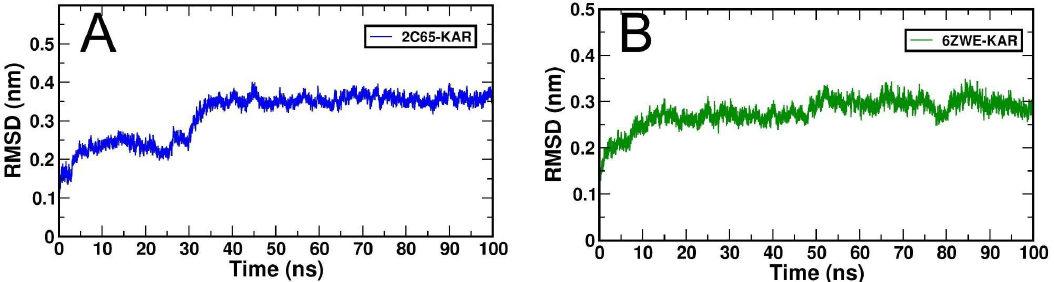
Figure 6. Generated RMSD plots for both docking complexes from MD simulation at 100 ns. ( A ), RMSD plot of 2C65-KAR and ( B ), RMSD plot of 6ZWE-KAR.